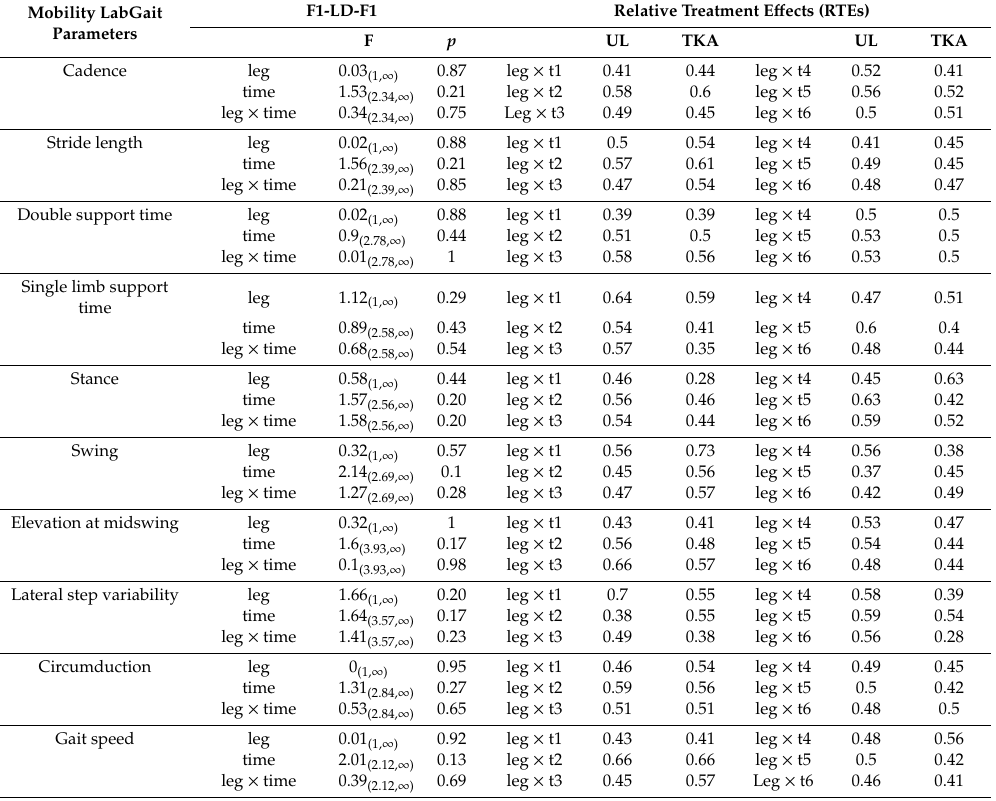
Table 2. One-factor longitudinal analysis of Mobility LabGait